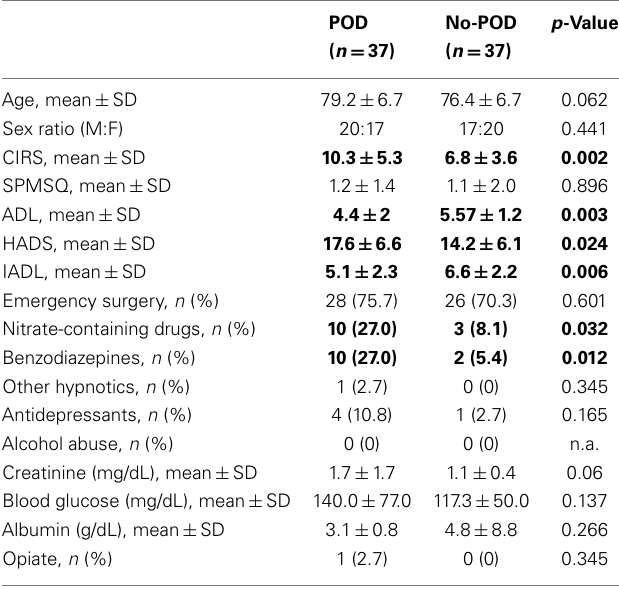
Table 1 | Baseline characteristics of patients in relation to post-operative delirium (POD) onset .